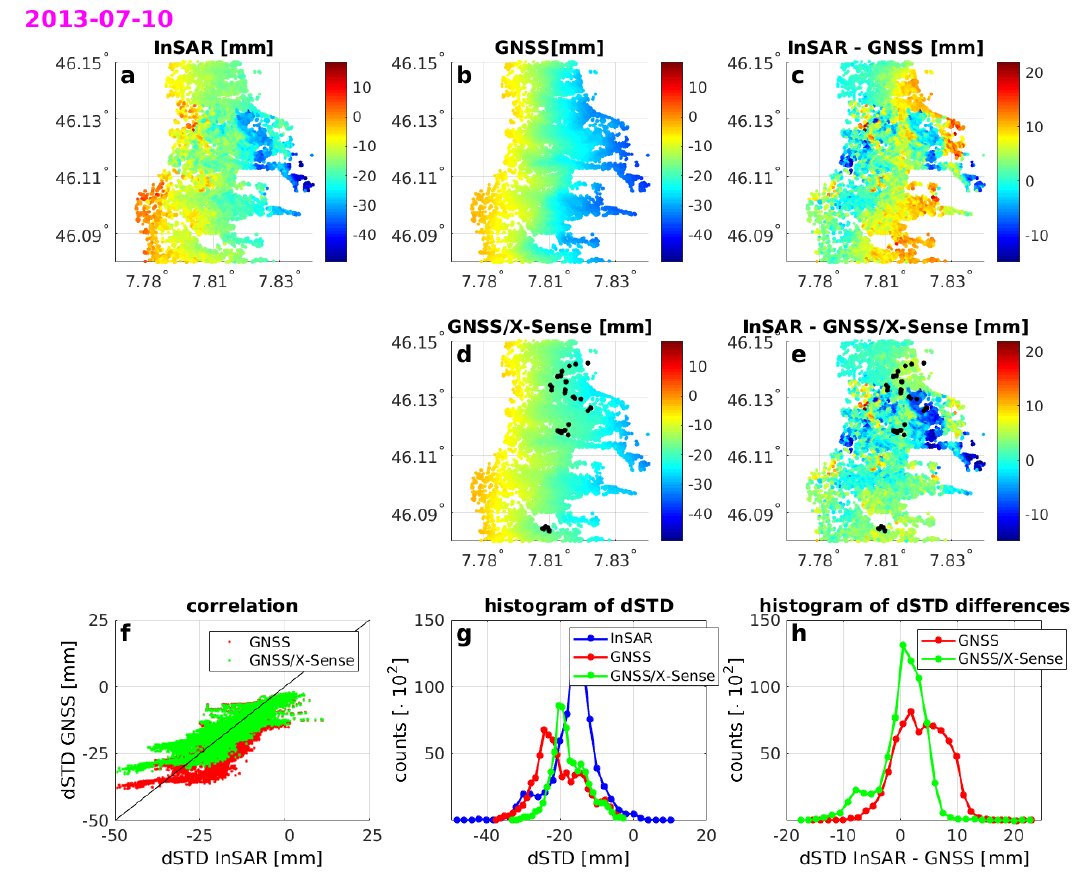
Figure 12. Comparison between InSAR and GNSS-based estimates for 10 July 2013 for a limited area. The plots show ( a ) InSAR-based dSTD s for all PS points; ( b ) GNSS-based dSTD s for all PS points; ( c ) the differences between ( a , b ); ( d ) the combined GNSS/X-Sense estimates; ( e ) the differences between ( a , d ); ( f ) the correlation between InSAR and GNSS or GNSS/X-Sense estimates; ( g ) the histograms of the values and ( h ) the histogram of differences between InSAR and the two GNSS-based models. The white star indicates the reference point, red dots the GNSS stations within the closest research area and black dots the X-Sense